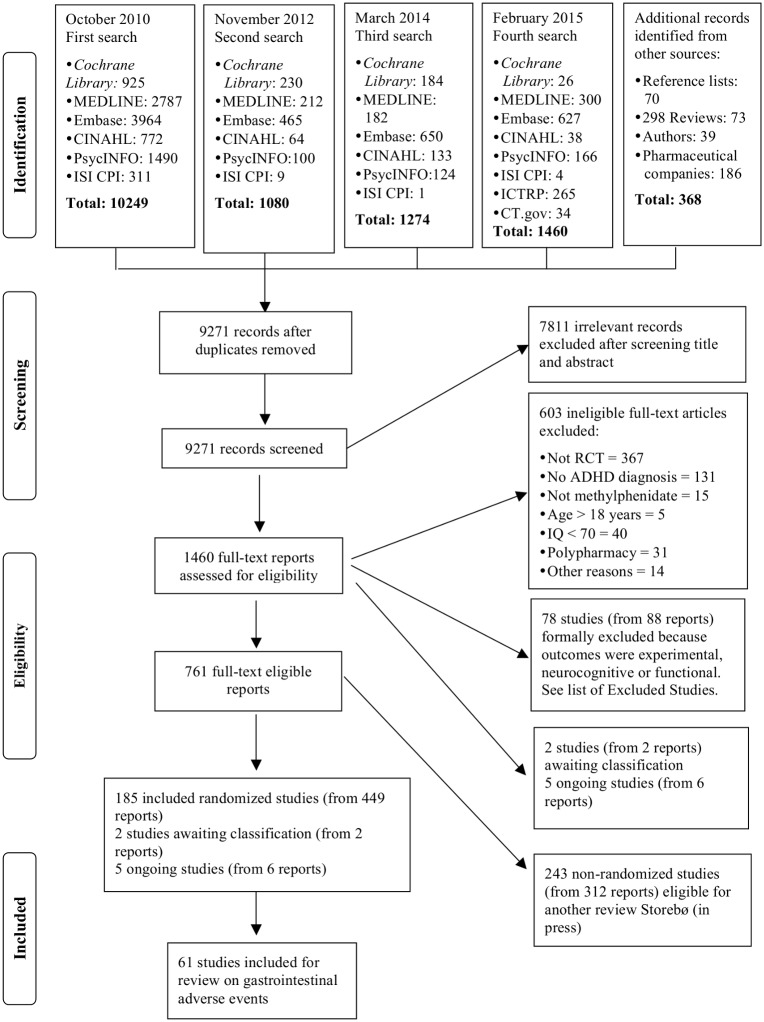
PRISMA flow chart [34].